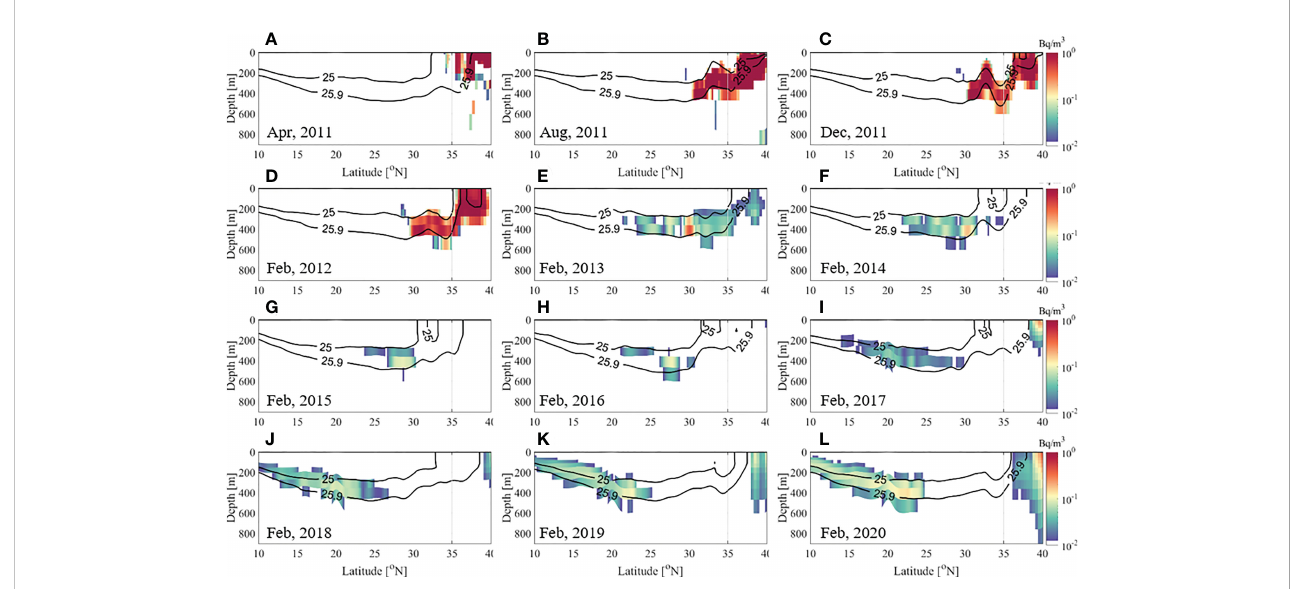
FIGURE 7 Monthly vertical section of 137 Cs concentration along line L1 (149°E) in April (A – C) , August and December 2011 and each February (D – L) from 2012 to 2020. The background contour represents the potential density (kg/m 3 ). 137 Cs concentration was corrected for radioactive decay (30